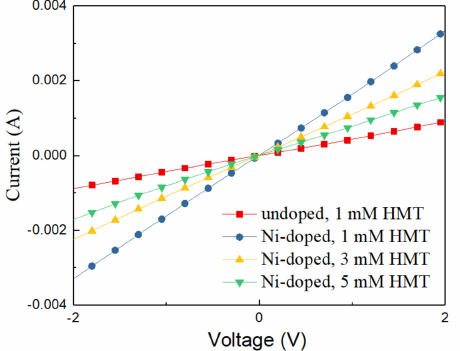
Figure 7. I–V characteristics of the electron-only devices based on the undoped and Ni-doped ZnO NWLs with HMT concentrations of 1, 3, and 5